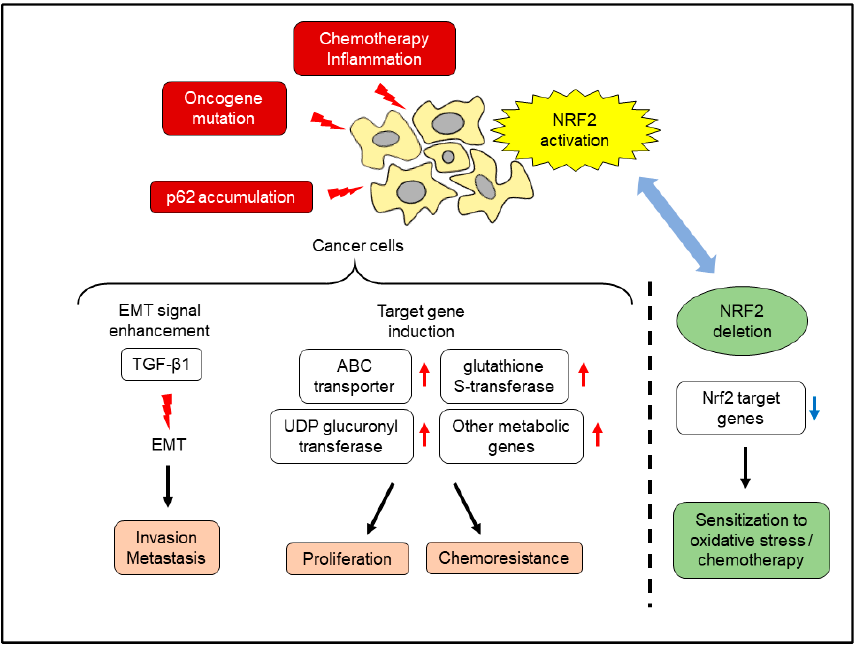
Figure 4. Effects of NRF2 activation in pancreatic cancer cells. ABC, ATP binding cassette; TGF- β 1, transforming growth factor- β 1.